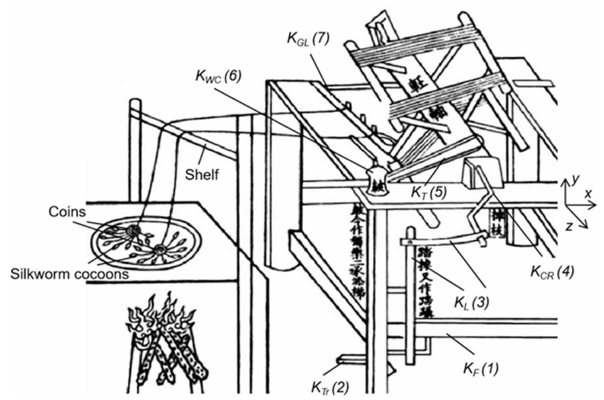
Figure 4. Reeling wheel (Wang,